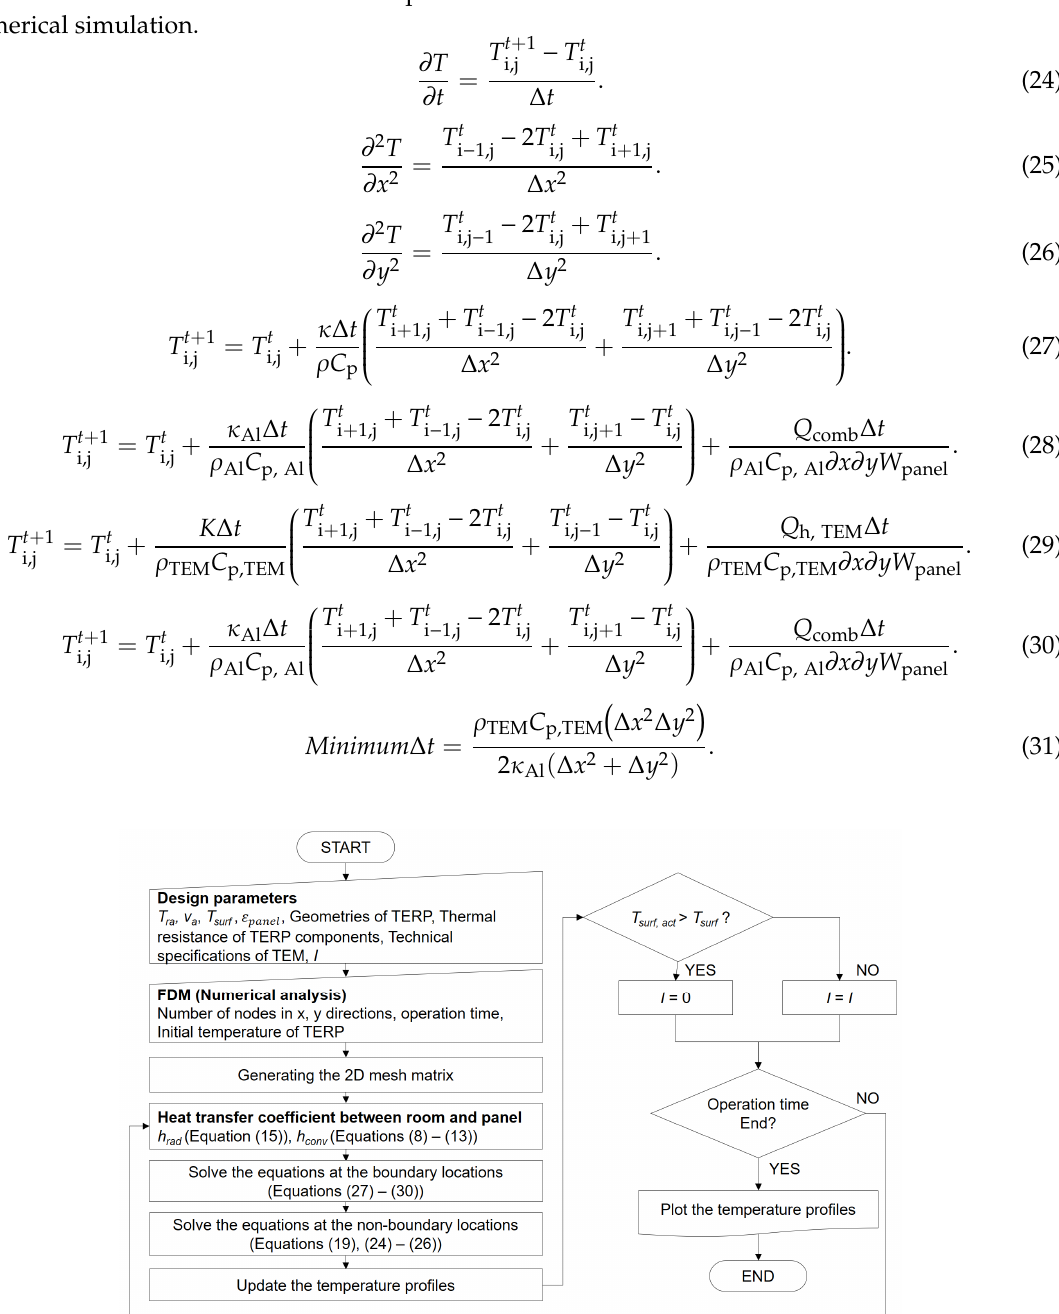
Figure 4. Algorithm of the numerical simulation for the TERP in the heating operation.